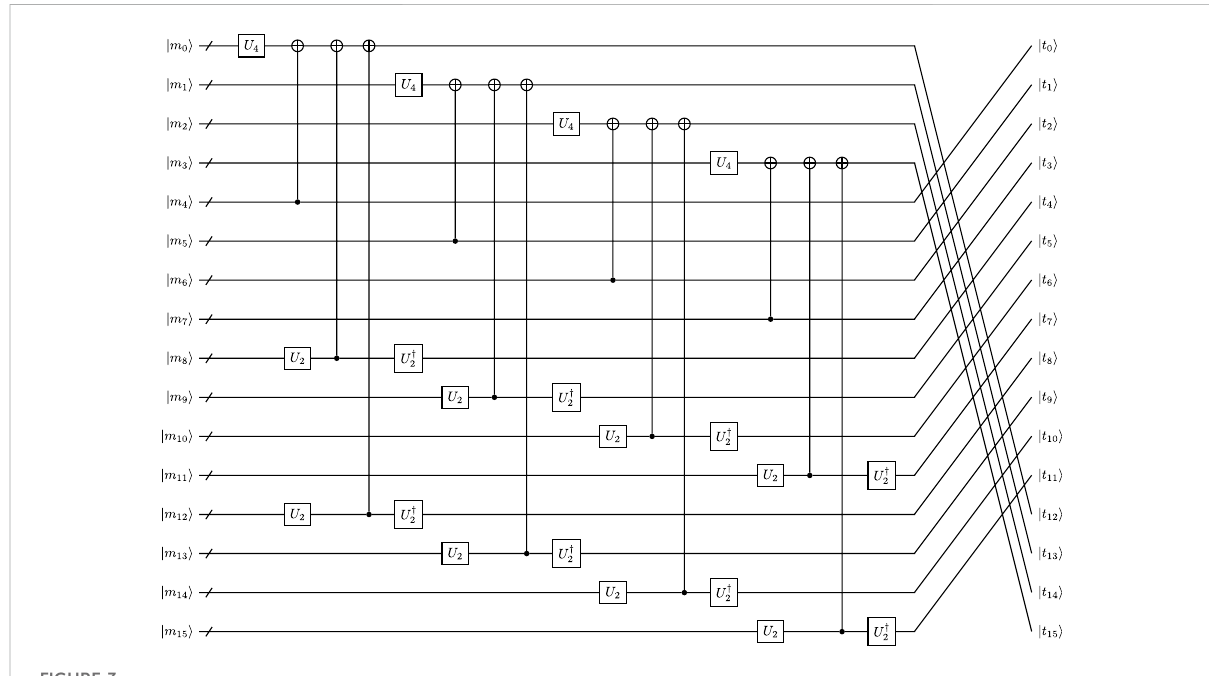
FIGURE 3 Quantumcircuitofmatrix A ,where U 2 and U 4 arequantumcircuitsofoperations2and4respectively. U † 2 representstheinversequantumcircuit of U 2 . Each m j and t j contains four qubits, where j = 0, 1, ... ,